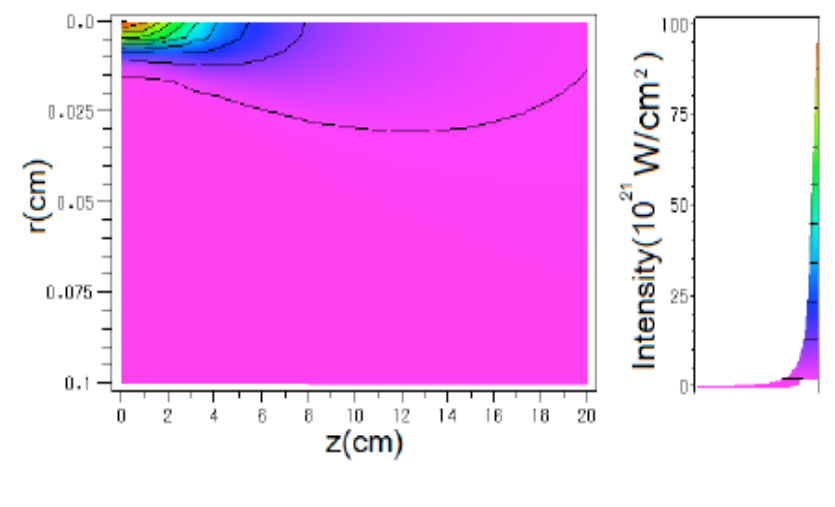
Figure 13. Contour of Gauss laser beam intensity in the reactor. (0,0) is a center position for